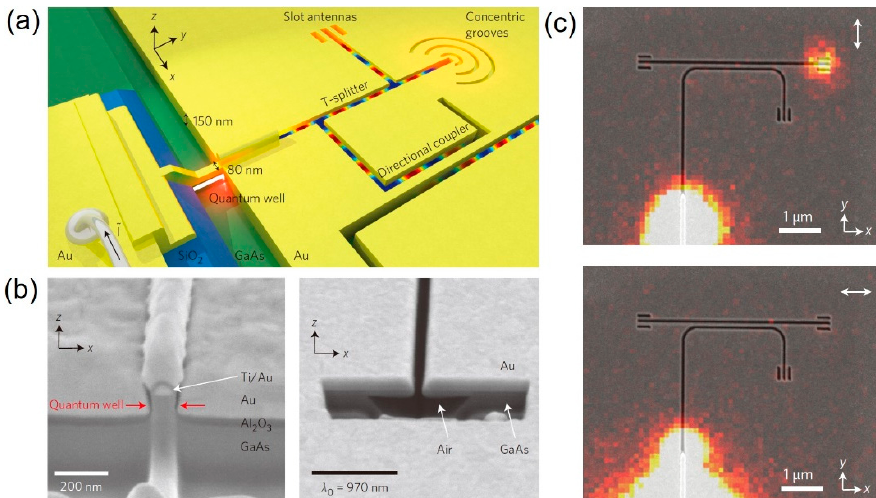
Figure 13. Electrically driven plasmonic light sources and integrated optical nanocircuit. ( a ) Electrically driven subwavelength optical nanocircuits. Schematic illustration of the nanocircuit, showing nano-LED light source, plasmonic waveguides, T-splitter, slot antennas, and directional coupler (left, top). SEM image of the cross section of nano-LED and plasmonic slot waveguide (left, bottom), exhibiting a layered structure including GaAs/InGaAs multiple quantum wells (MQWs) and air-suspended slot waveguide structure. EL images, showing gap-plasmon propagation in metallic slot waveguide, coupled to the directional coupler, and polarized re-emission at the slot antenna of the coupler (right, top, and bottom) [51]. Figure reproduced with permission from Springer Nature